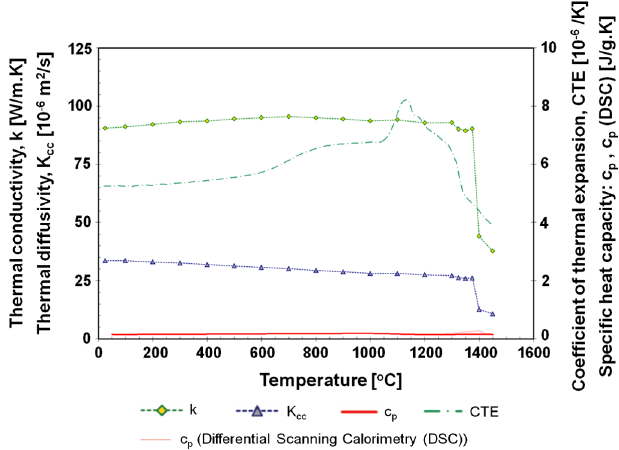
FIG. 9. Thermophysical properties of INERMET ® 180 mea- sured between room temperature up to 1450 °C at the Austrian Institute of Technology.